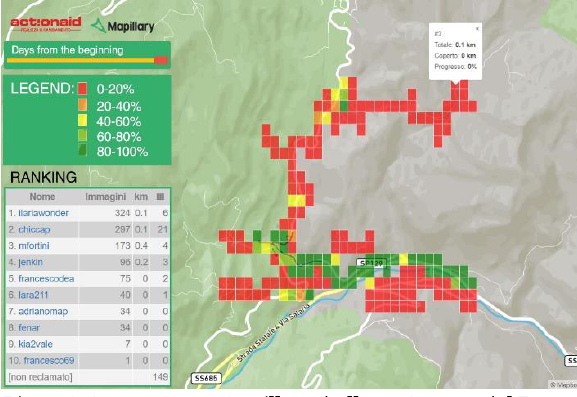
Figure 1 . Areas to map, Mapillary challenge Arquata del